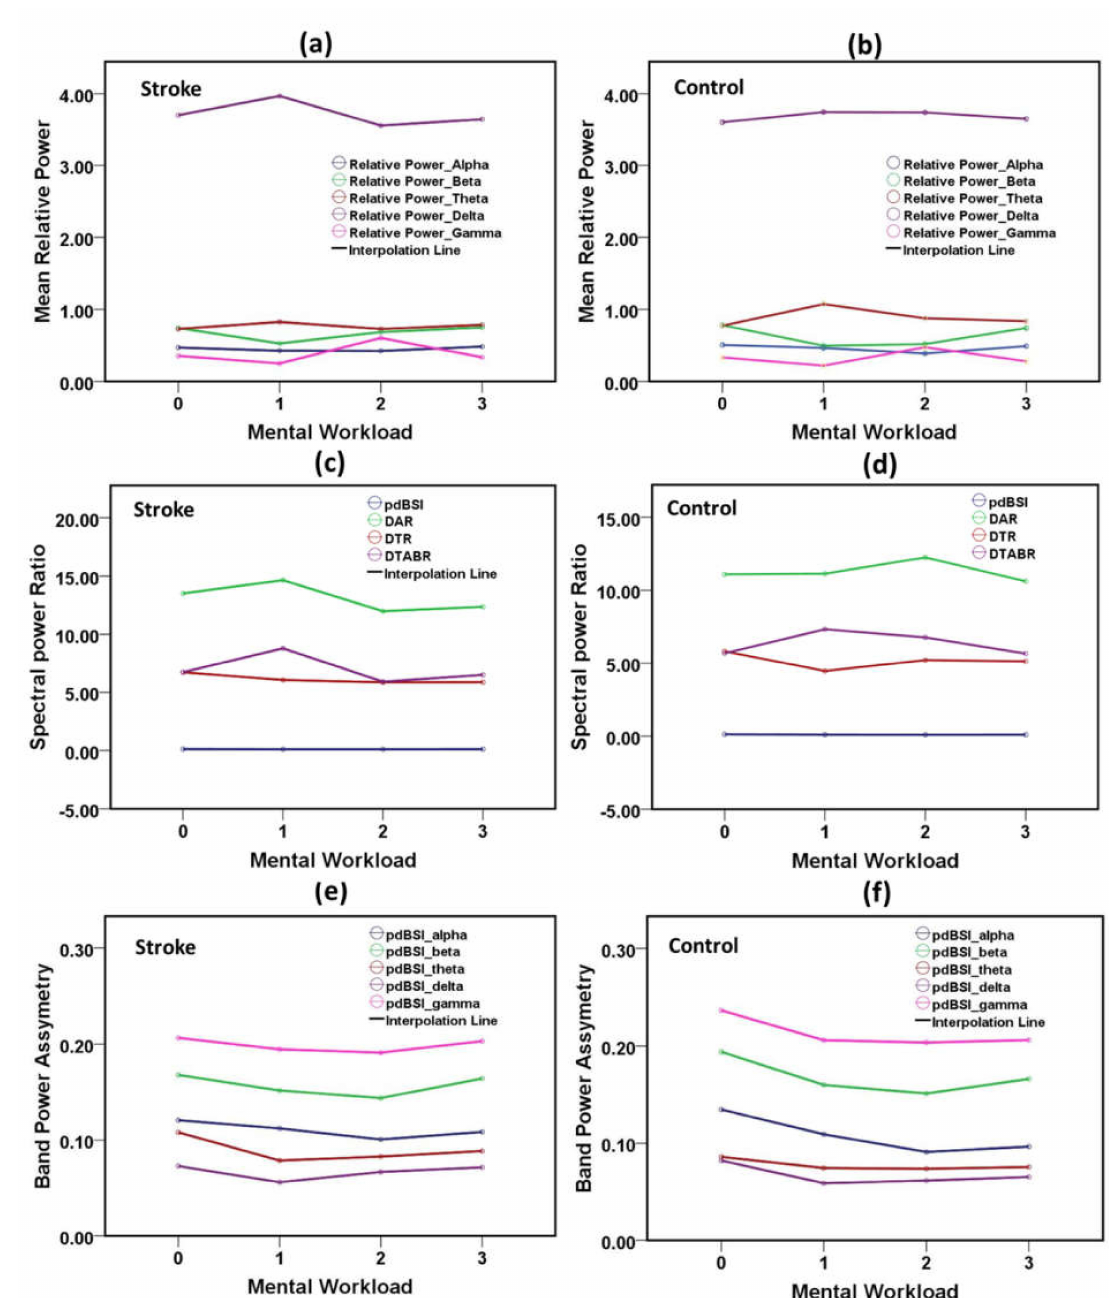
Figure 7. Variation of EEG spectral features, the ratios of power features and pdBSI band-specific components with mental workload. ( a ) Spectral RP with the mental workload for stroke group, ( b ) spectral RP with the mental workload for the control group, ( c ) frequency-band power ratios with the mental workload for stroke group, ( d ) frequency-band power ratios with the mental workload for the control group, ( e ) spectral components of pdBSI with the mental workload for stroke group, ( f ) spectral components of pdBSI with the mental workload for the control